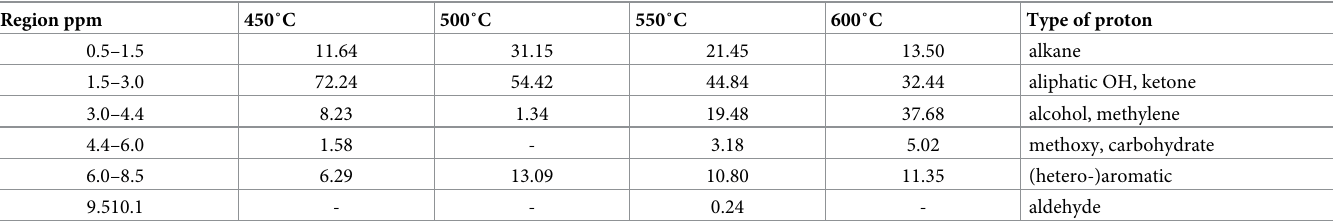
Table 2. 1 H NMR results for oil generate at different pyrolytic temperatures (in area %). Region ppm 450˚C 500˚C